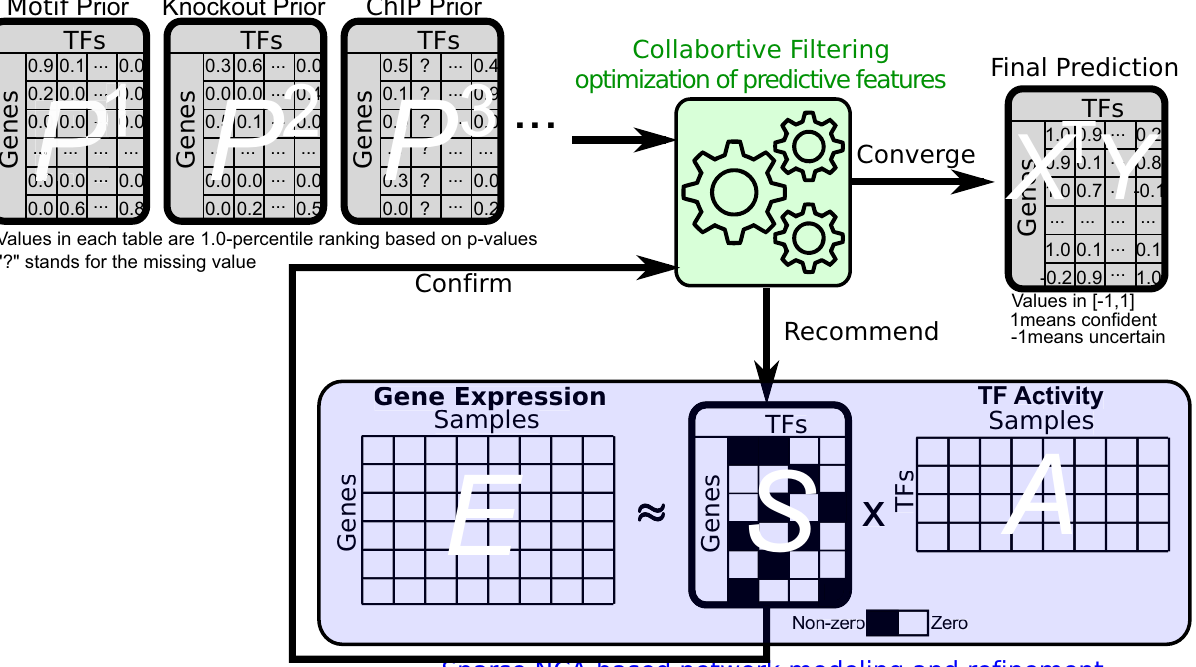
Fig. 1 Method overview. Collaborative fi ltering (CF) and NCA-based gene expression modeling alternatively inform each other during a joint optimization process: CF recommends edges to be con fi rmed by the NCA model and used to improve